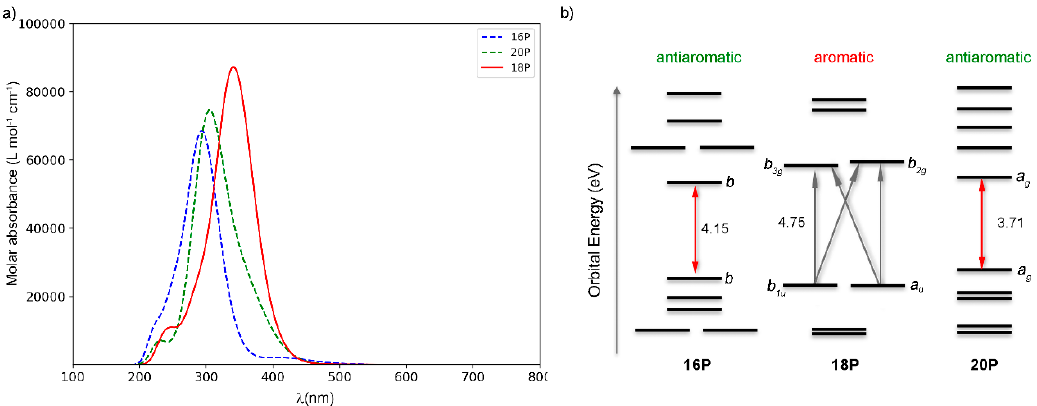
Figure 10. UV/vis absorption spectra of regular porphyrin ( 18P ), oxidized porphyrin ( 16P ) and reduced porphyrin ( 20P ) ( a ) together with the MO energy diagram of selected molecular orbitals ( b ).